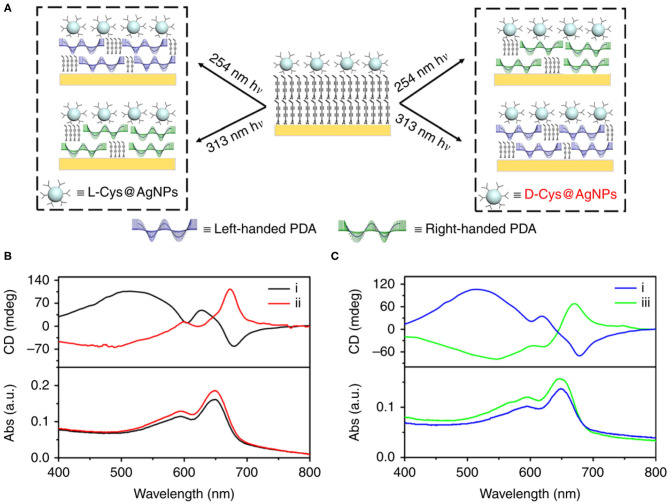
(A) Handedness of PDA depending on both chiral configuration of ligands on plasmonic nanoparticles (L- vs. D-) and the wavelength of UV irradiation (254 vs. 313 nm). Handedness of PDA obtained with all four possible combinations. Left-handed PDA was obtained using 254 nm irradiation assisted with L-Cys@NPs or 313 nm irradiation assisted with D-Cys@NPs. Right-handed PDA was obtained using 254 nm or 313 nm irradiation assisted with L-Cys@NPs. (B) CD spectra showing that chirality of PDA was reversed using (i) L- and (ii) D-Cys@AgNPs upon irradiated with 254 nm unpolarized light. (C) CD spectra showing that chirality of PDA was reversed using (iii) 313 nm irradiation instead of (i) 254 nm unpolarized light in the presence of L-Cys@AgNPs. Reprinted with permission from He et al. (2020). Copyright 2020, Nature.